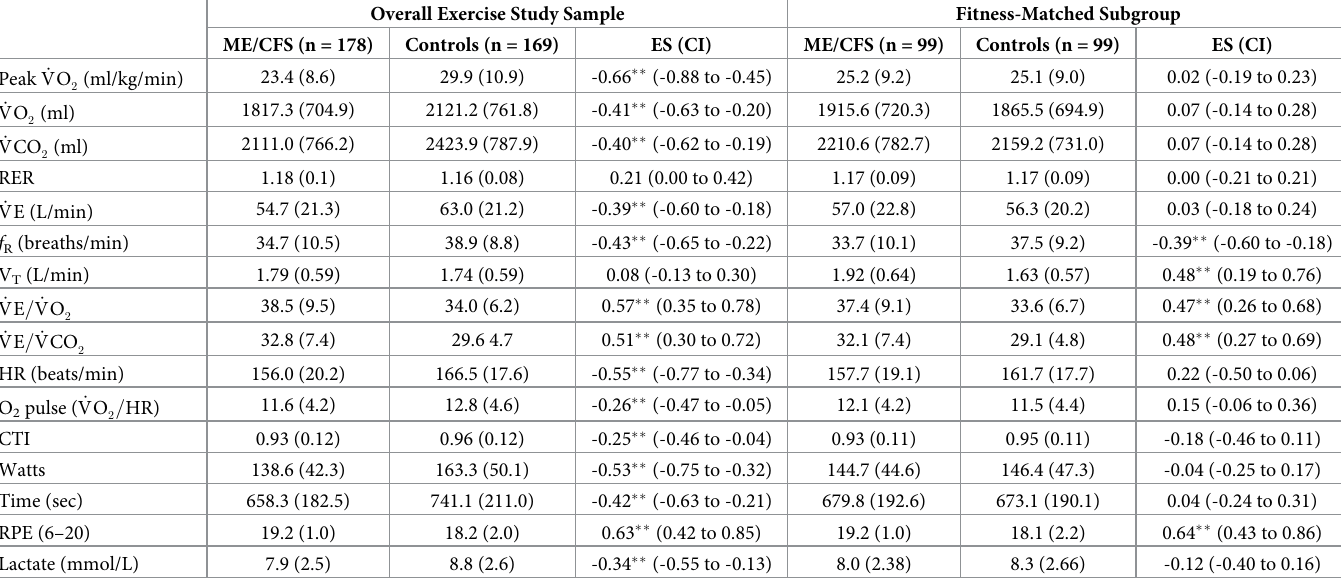
Table 4. Cardiopulmonary responses at peak exercise in ME/CFS patients and controls. Overall Exercise Study Sample Fitness-Matched